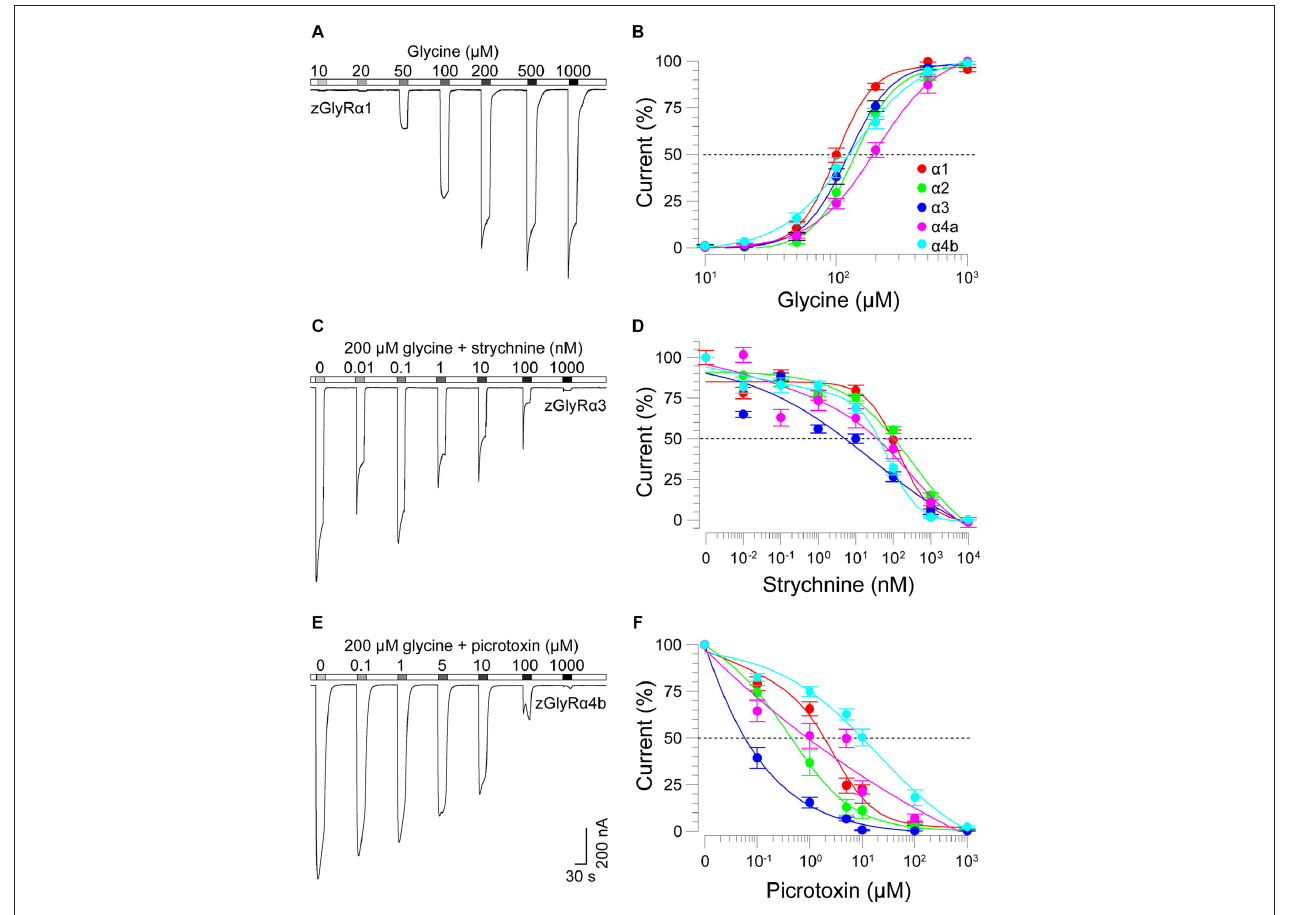
FIGURE 4 | zGlyR α subunits form functional homomeric receptors that are activated by glycine, and inhibited by strychnine and picrotoxin. (A) Two-electrode voltage-clamp recording from an oocyte injected with five femtomoles of zGlyR α 1 cRNA exposed to serial application of glycine of increasing amount. Ten oocytes were used for each assay. (B) Cumulative dose-response relationship of glycine-evoked currents. The amplitude of each glycine-evoked response was normalized to the maximally-evoked current for each oocyte ( n = 10). Values here and elsewhere represent the average ± SEM. Dashed line denotes EC 50 . (C,E) Recordings from oocytes exposed to glycine and increasing amounts of strychnine or picrotoxin, respectively ( n = 10). (D,F) Cumulative dose-response relationships of strychnine and picrotoxin-blocked currents ( n = 10). Extent of blockade was normalized to the current amplitude evoked by 200 µ M glycine in each oocyte. Dashed lines denote IC 50 s